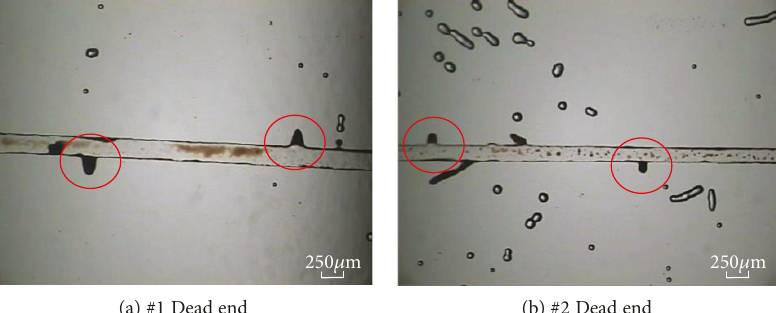
Figure 5: Distribution characteristics of residual oil at dead ends after glycerin fl ooding (the dark area is oil, and the lighter the color is, the lower the saturation is; the light area represents the displacing fl